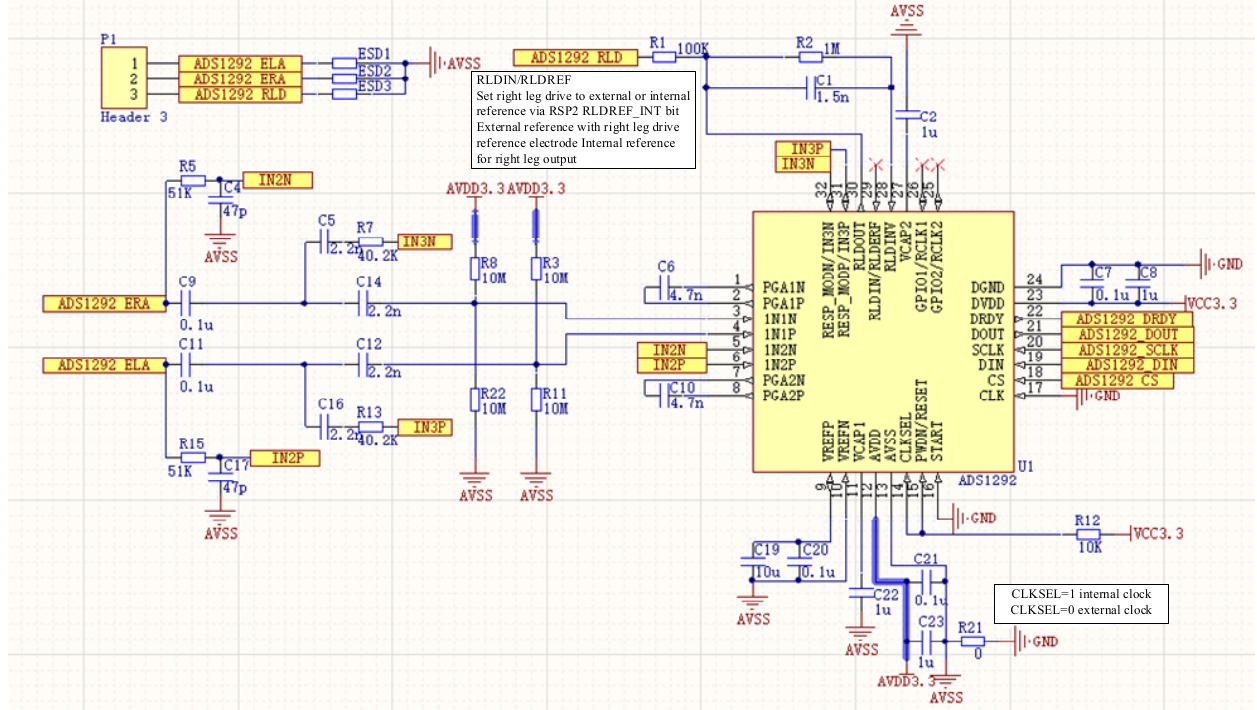
Figure 3. Schematic diagram of sEMG acquisition circuit based on ADS1292R. The signal transmission part uses a Bluetooth transmission method. Bluetooth is based on low-cost proximity wireless connection; low-power and micro-power consumption are its characteristics. The Bluetooth module used in this paper is an hc-05 Bluetooth module. The schematic diagram of the Bluetooth system is shown in Figure 4.